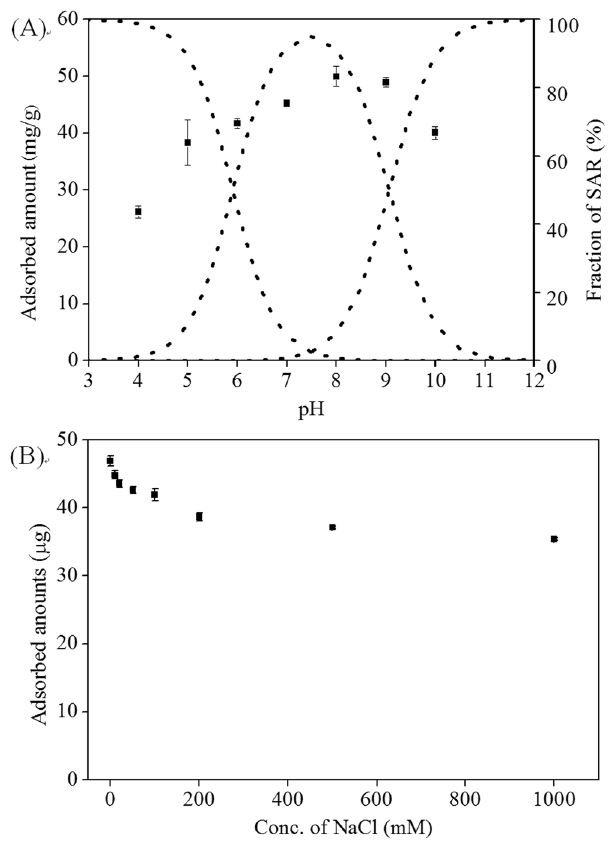
Figure 4. ( A ) Effect of pH on the adsorbed amount of SAR on the PDA@GO/Fe 3 O 4 nanoparticles (squares) and fraction of SAR at different pH (dots), ( B ) effect of ionic strength on the adsorbed amount of SAR on the